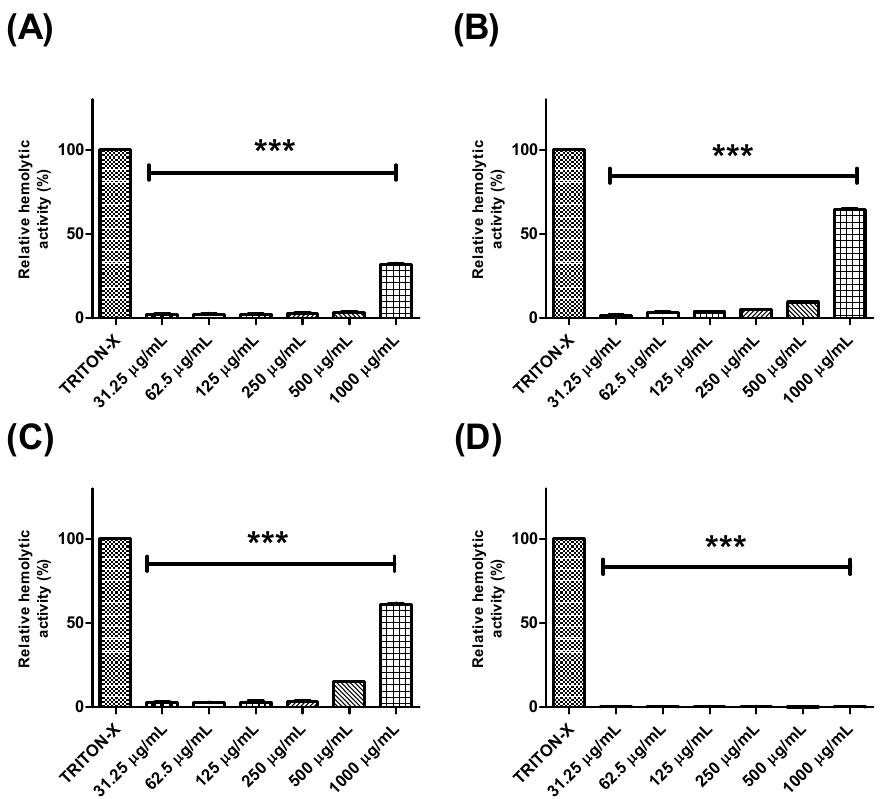
Figure 2. Hemolytic activity of the crude extracts of Buchenavia tetraphylla leaves. ( A ) BTHE (hexane extract); (B ) BTCE (chloroform extract); ( C ) BTEE (ethyl acetate extract); ( D ) BTME (methanolic extract). *** Significant di ff erences in relation to triton-X ( p < 0.0001). The results are expressed as the mean ± standard deviation calculated from three independent assays performed in quadruplicate ( n = 4